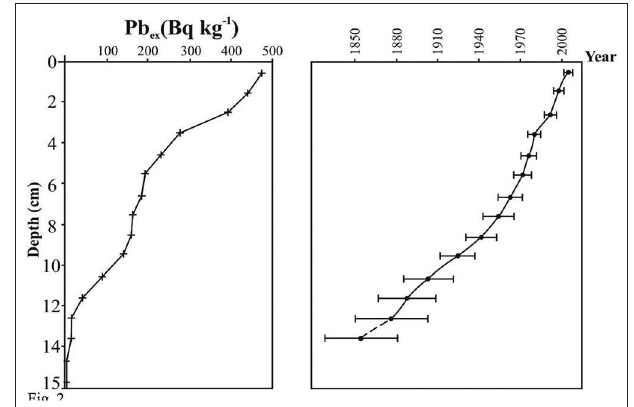
FIGURE 2 | Vertical profiles of 210 Pbex of Manzherok Lake sediment core and 210 Pb chronologies. The dashed line indicates an interpolation result of age (see text for